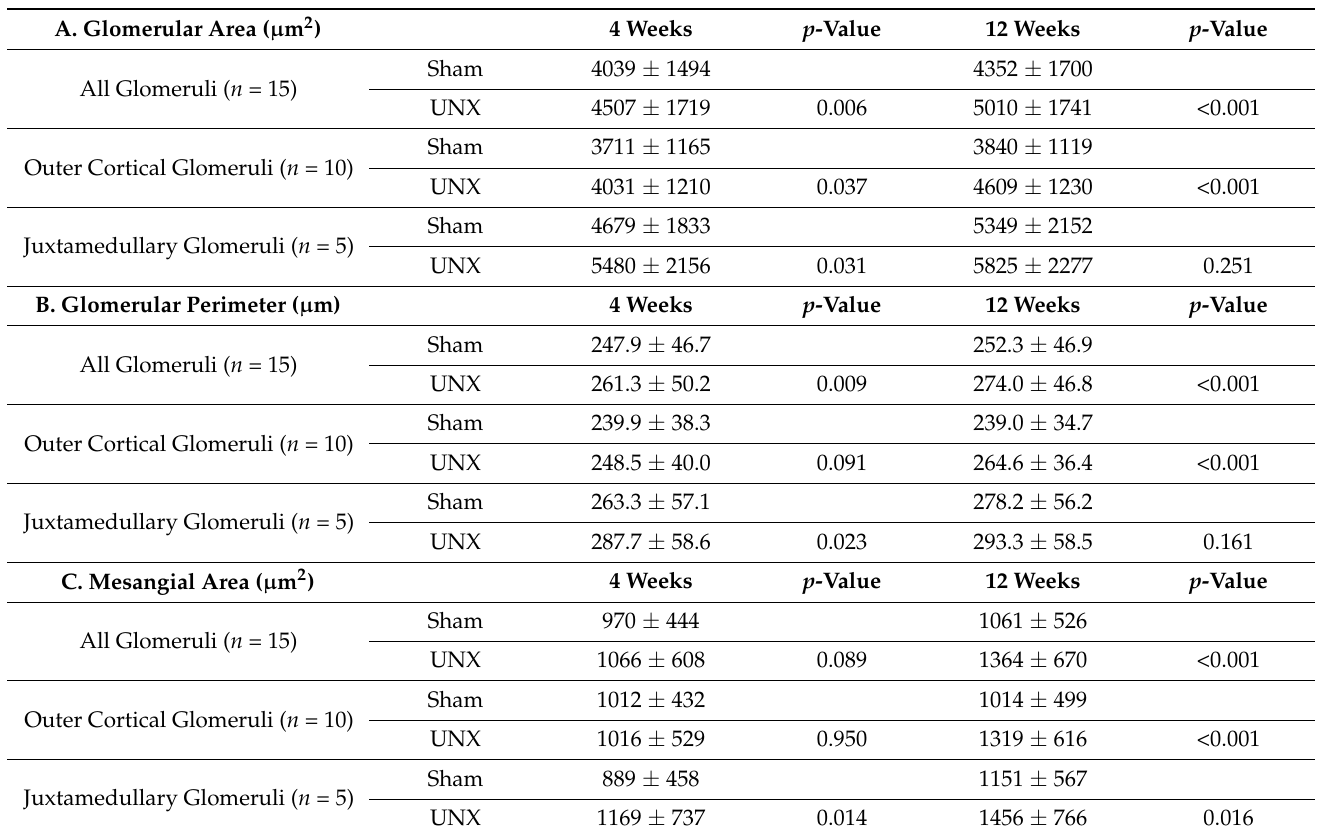
Table 1. ( A – D ): The table shows the glomerular area ( A ), glomerular perimeter ( B ), mesangial area ( C ), and mesangial cell count ( D ) in TOPGAL animals at 4 and 12 weeks following unilateral nephrectomy or sham treatment at 4 weeks of age. The measurements were performed on 15 glomeruli (10 outer cortical glomeruli and 5 inner juxtamedullary glomeruli) in a kidney section stained with Periodic Acid Schiff stain. This was performed on 12 sham and 12 UNX animals at 4 weeks and 11 sham and 12 UNX animals at 12 weeks. The values are shown as the Mean ± SD; the p-values were obtained using unpaired Students’ t